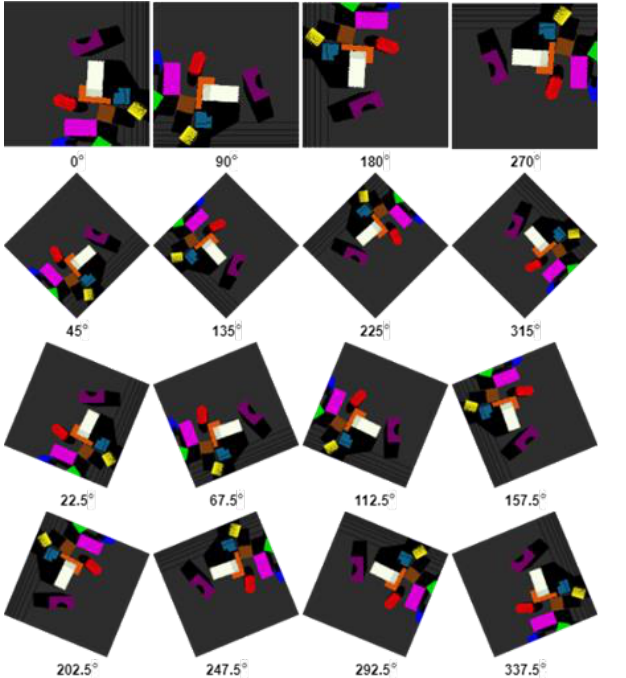
Figure 7. RGB-D heightmap rotations at 90 degrees (first row), 45 degrees (first and second row), and 22.5 degrees (all four rows).